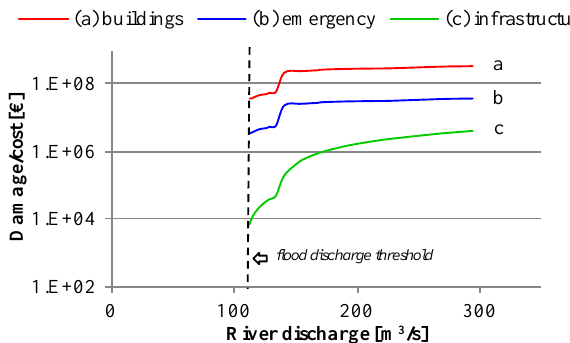
Fig. 5. Results of potential damage assessment and emergency costs Figure 5. Results of potential damage assessment and emergency costs estimation; 2 estimation: comparison among (a) buildings (structure + comparison